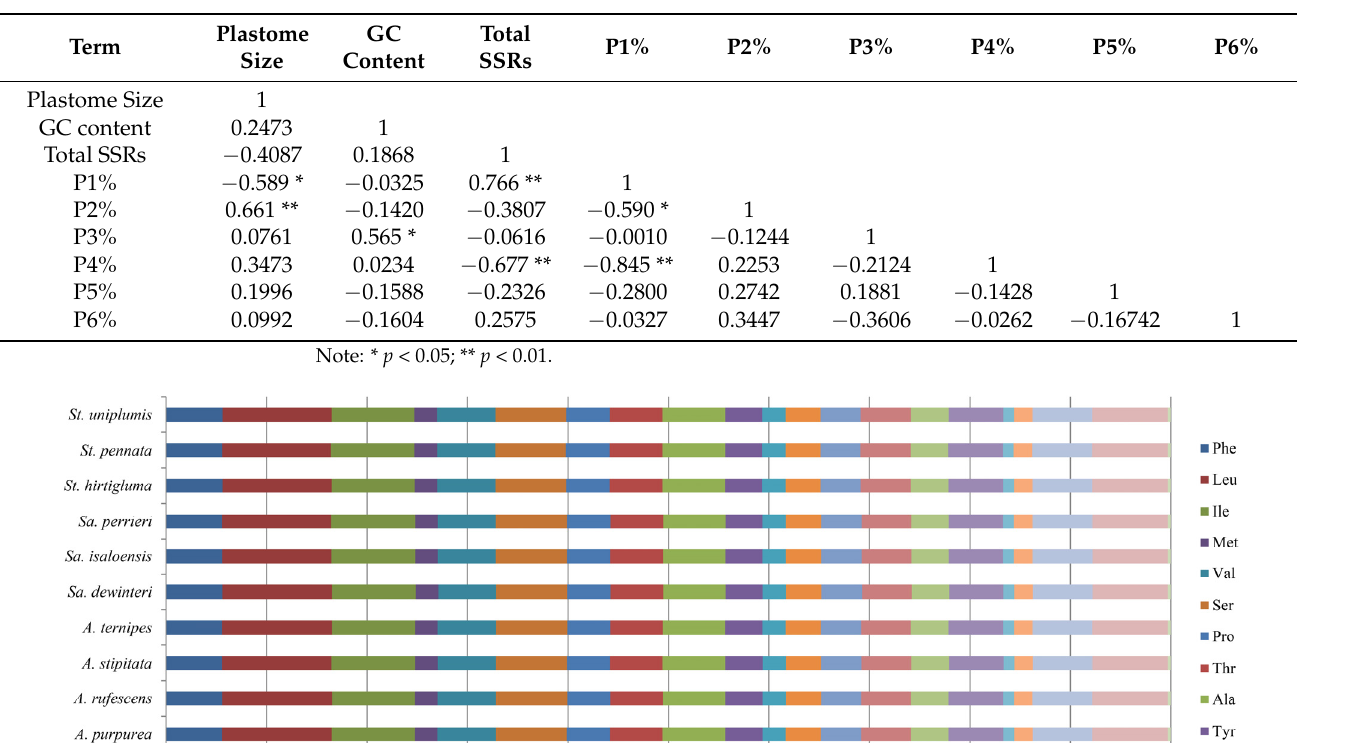
Table 3. Correlation analysis between cpSSRs and plastome size and CG content in 16 Aristidoideae species.